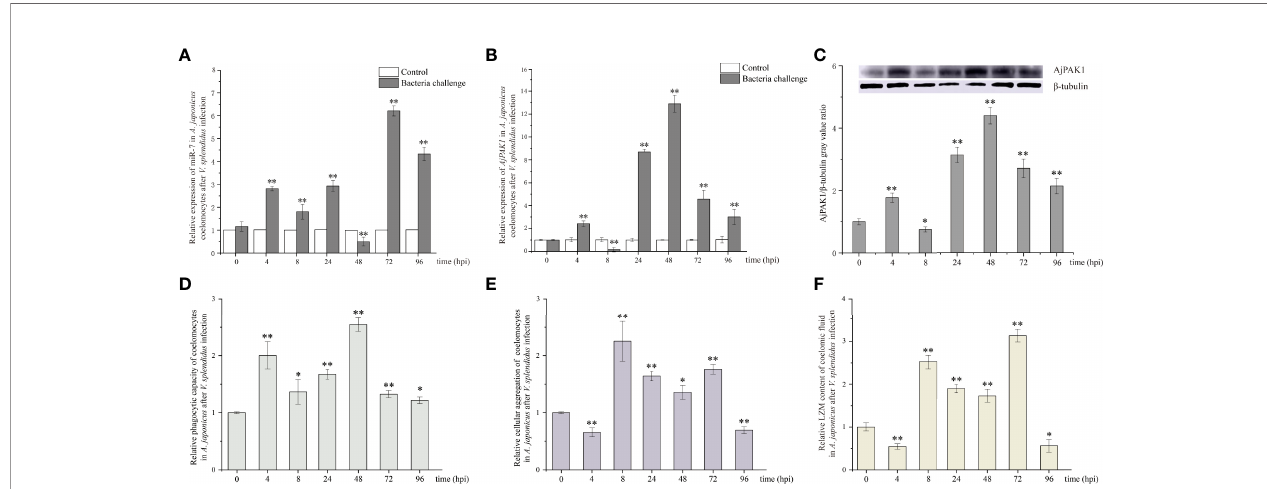
FIGURE 2 | Relative expression of miR-7 and AjPAK1 (mRNA and protein) and phagocytic capacity, cellular agglutination, and lysozyme (LZM) content analyses in A. japonicus after Vibrio splendidus infection. (A) Relative expression of miR-7 in A. japonicus coelomocytes after V. splendidus infection. (B) Relative expression of AjPAK1 in A. japonicus coelomocytes after V. splendidus infection. (C) Relative expression of AjPAK1 protein in A. japonicus coelomocytes after V. splendidus infection. (D) Relative phagocytic capacity of coelomocytes in A. japonicus after V. splendidus infection. (E) Relative cellular agglutination of coelomocytes in A. japonicus after V. splendidus infection. (F) Relative LZM content of coelomic fl uid in A. japonicus after V. splendidus infection. ** represents an extremely signi fi cant difference compared with 0 hpi ( P < 0.01); * represents a signi fi cant difference compared with 0 hpi ( P <